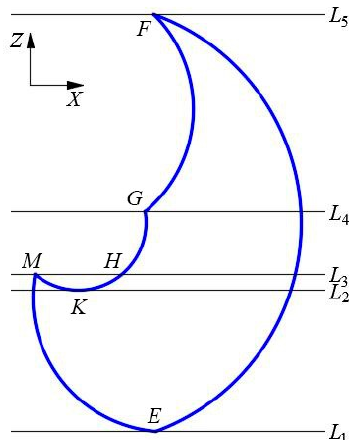
Figure 8. Schematic diagram of the contour of the workspace in the XZ plane.